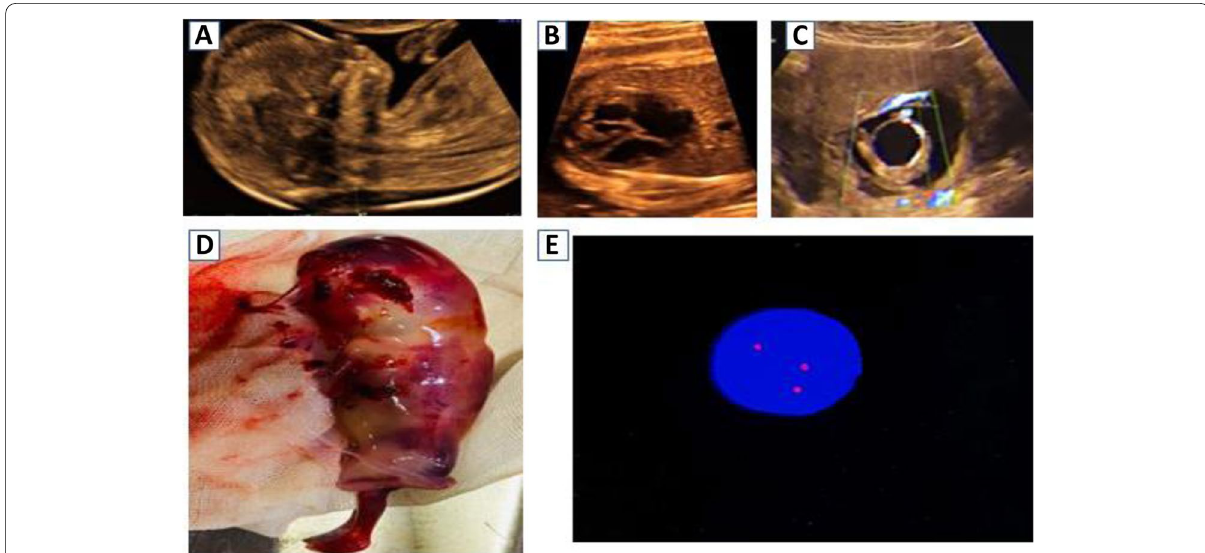
Fig. 3 A case of trisomy 21 detected in the first trimester. A Midsagittal view of the fetal face showing hypoplastic nasal bone and increased nuchal translucency. B Transverse views of the fetal chest at the level of the four chambers showing an atrioventricular septal defect. C Axial view of the fetal pelvis showing megacystis and single umbilical artery. D A postmortem image confirms the presence of the above findings. E FISH technique showing trisomy 21